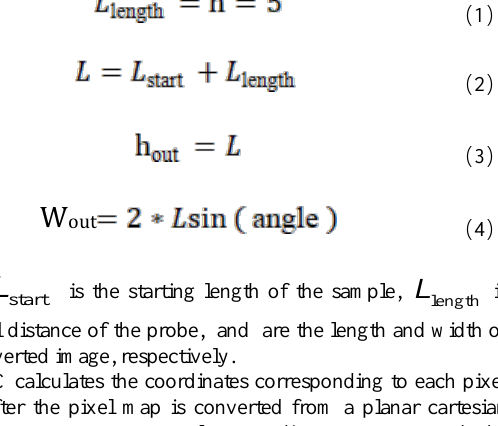
Figure C calculates the coordinates corresponding to each pixel